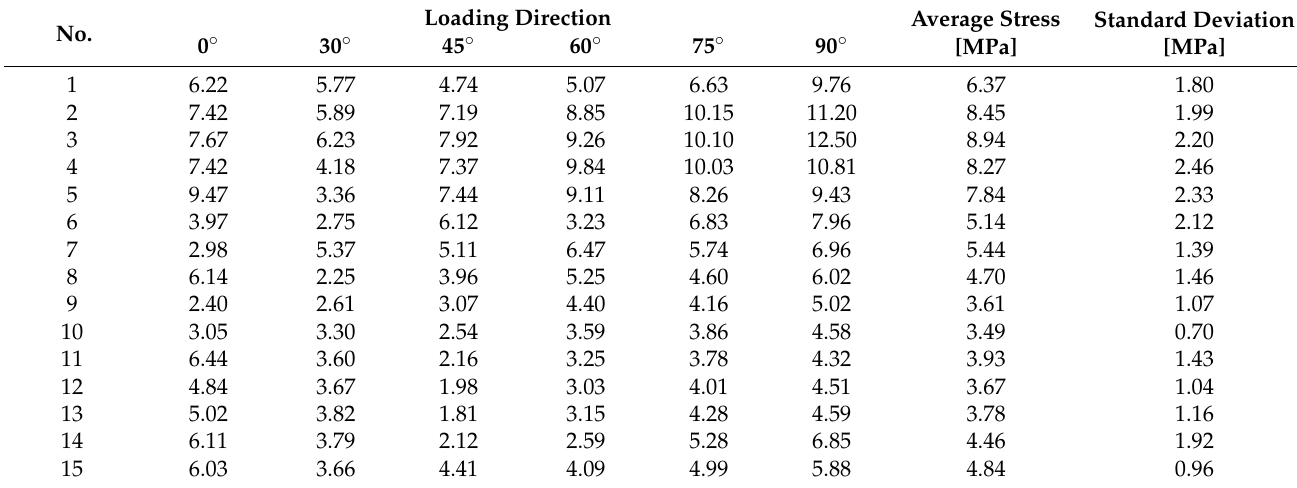
Table 7. Stress values in adhesive cement.